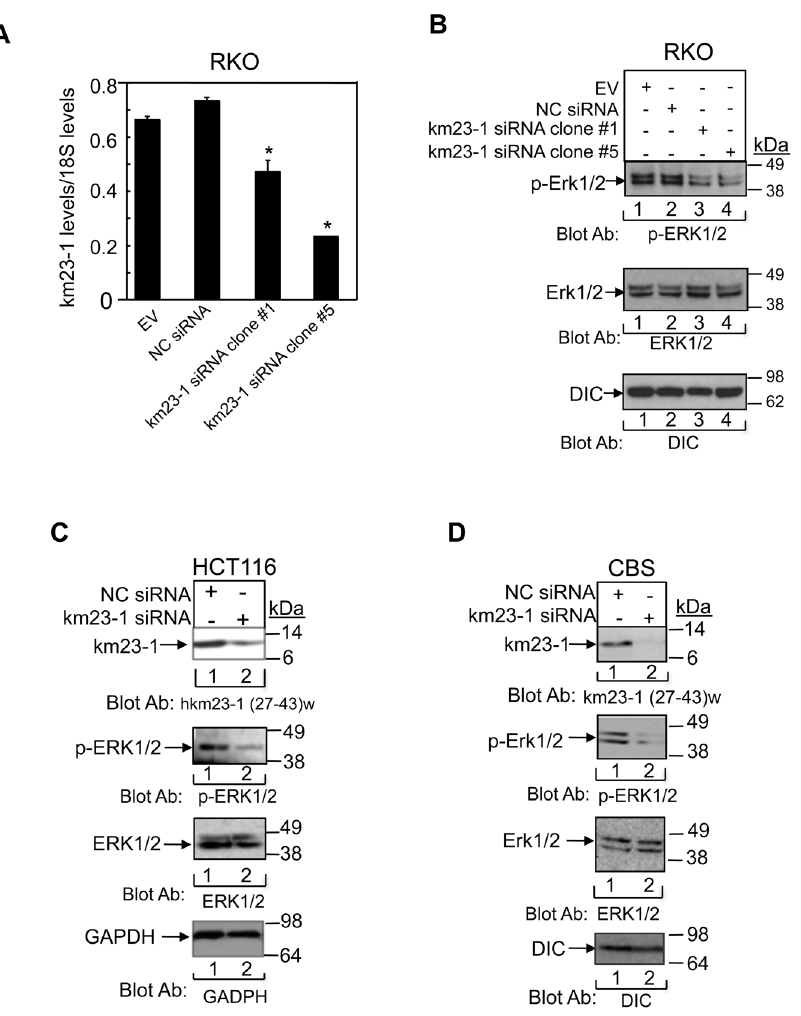
Figure 1. Depletion of km23-1 blocks constitutive ERK activation in human CRC cells. A. EV, NC siRNA, and km23-1 siRNA stable transfectants (clones 1 and 5) were used to isolate RNA. RT-PCR was performed and products were analyzed as described in the ‘‘Materials and Methods.’’ The data plotted are the mean 6 SE of three independent experiments. *p , 0.01 compared to the NC siRNA. B: Western blotting of phospho- and total protein expression levels for ERK1/2 in RKO human CRC cells. Bottom , DIC protein was assessed as a loading control. Data are representative of three independent experiments. C : Western blotting of phospho- and total protein expression levels for ERK1/2 in HCT116 cells stably transduced with the lentiviral particles described in the ‘‘Materials and Methods.’’ Top, confirms knockdown of endogenous km23-1. Bottom , GAPDH protein was assessed as a loading control. Data are representative of three independent experiments. D: CBS cells were infected with either pilenti-NC siRNA-GFP or pilenti-km23-1 siRNA-GFP pools. 24 h after infection, Western blotting was performed using the indicated antibodies. Top , confirms knockdown of endogenous km23-1. Bottom , DIC protein was assessed as a loading control. Three independent experiments were performed and representative figures are